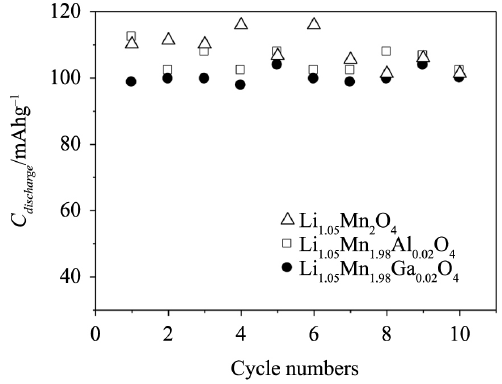
Figure 10. Discharge specific capacities of the electrodes of the oxides calcined at 750 °C for 120 min, in EC/DMC LiClO at i = 40 µA (C/1) and i C